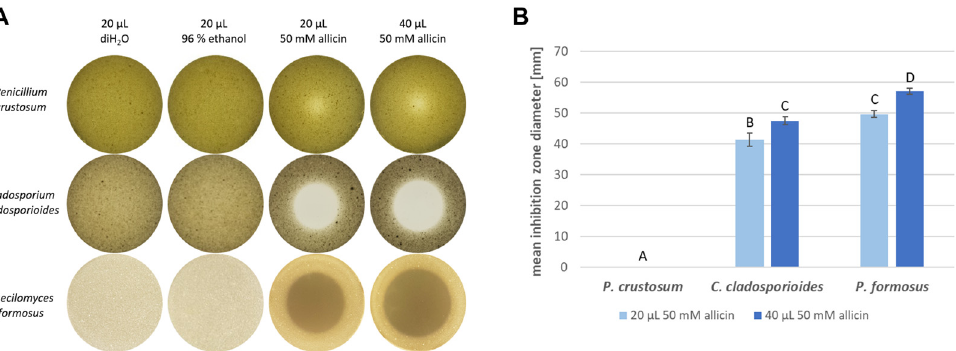
Figure 2. Allicin inhibits spore germination via the gas phase. ( A ) Fungal spores (10 6 spores per mL) were added to 20 mL PDA medium (50 °C). After the medium solidified, diH 2 O, 96% ethanol or 50 mM aqueous allicin solution were applied to the Petri dish lid. Triplicates of each fungal sample were prepared and incubated for 48 h. ( B ) n = 3, error bars show standard deviation. Same letter indicates no significant difference ( p > 0.05) in a One-Way RM ANOVA using the Holm–Šidák